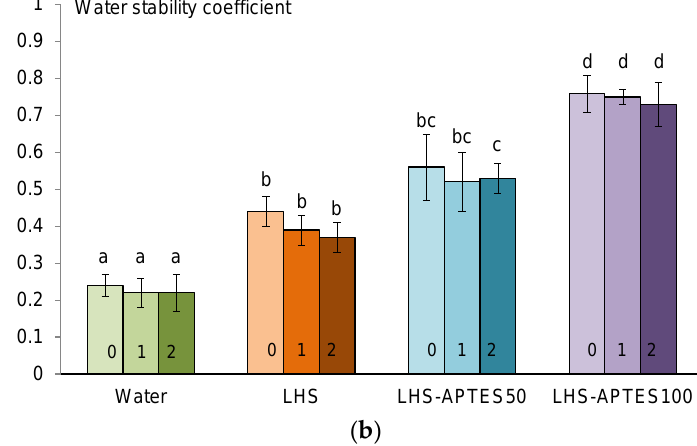
Figure 4. Water stability coefficient of soil aggregates treated with the LHS-APTES conditioner using three soaking-washing cycles: ( a ) after three consecutive soaking. The numbers in the columns indicate the soaking steps; ( b ) after two consecutive washing with water. The numbers in the columns indicate the number of washing steps (0 indicates no washing). Error bars represent standard deviation ( n = 3). Values with different letters are significantly different at p < 0.05.